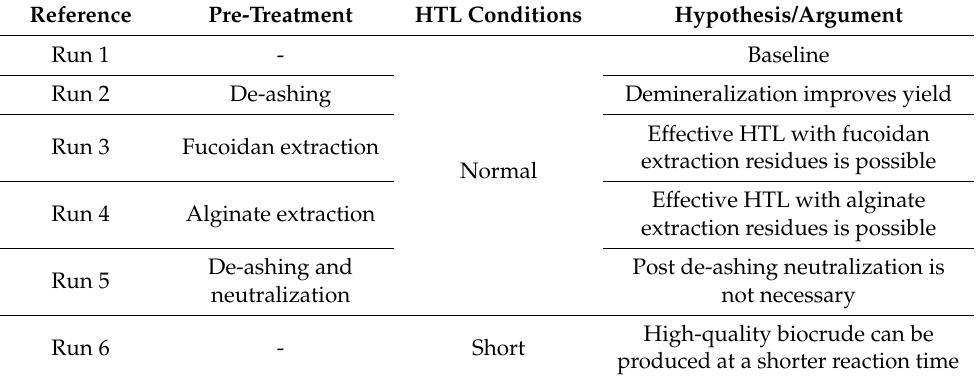
Table 5. HTL experimental